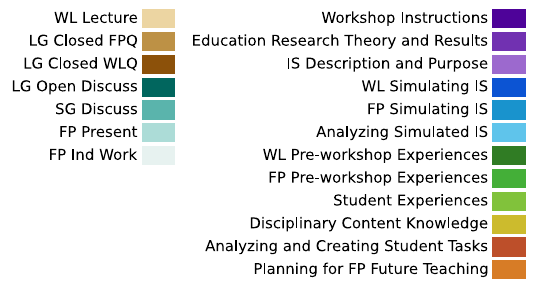
FIG. 1. Color key for the type-of-engagement (left) and focus- of-engagement (right) R-PDOT